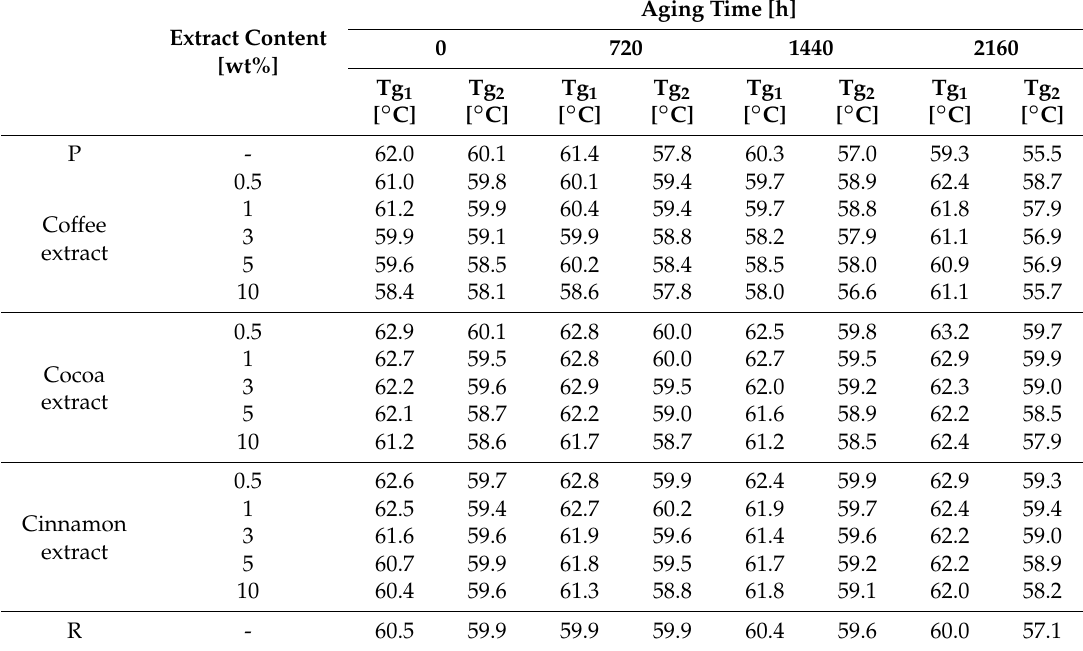
Table 3. Results of differential scanning calorimetry